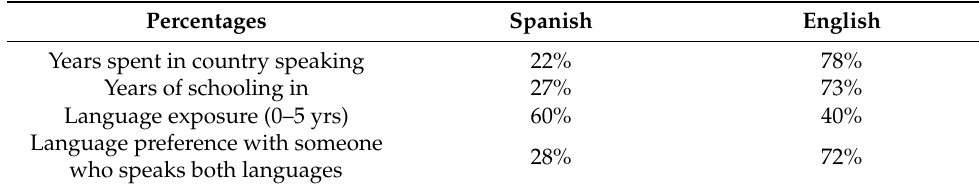
Table 3. Average responses to background